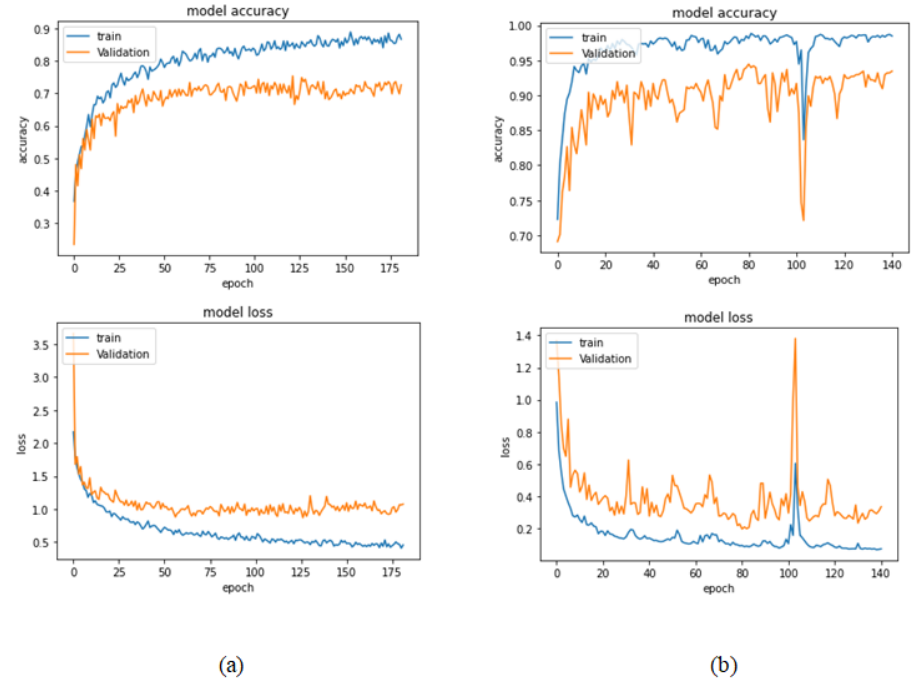
Figure 23. Learning curves for Xception at 0.0001 learning rate in 40× magnification-dependent multi-classification ( a ) Accuracy and loss curves of Phase 1 of training. ( b ) Accuracy and loss curves of Phase 2 of training.